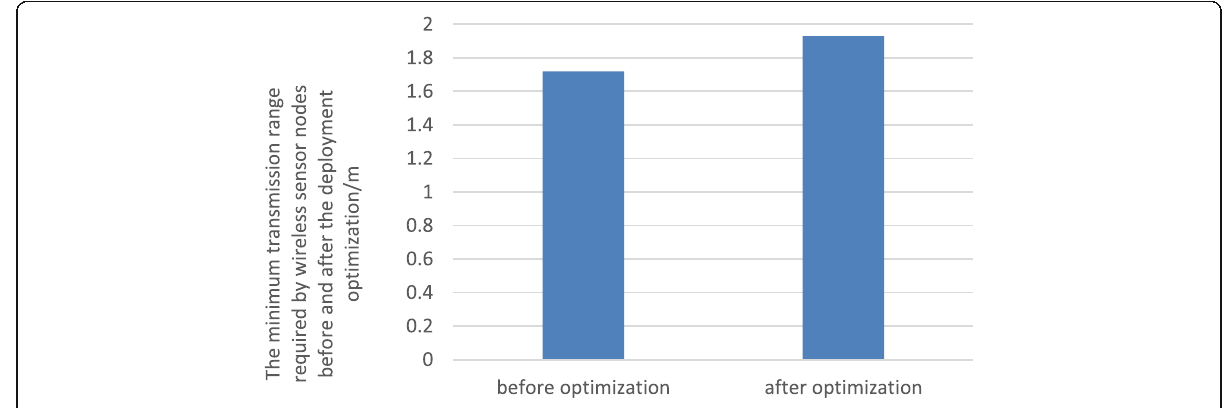
Fig. 8 The minimum transmission range required by wireless sensor nodes before and after the deployment